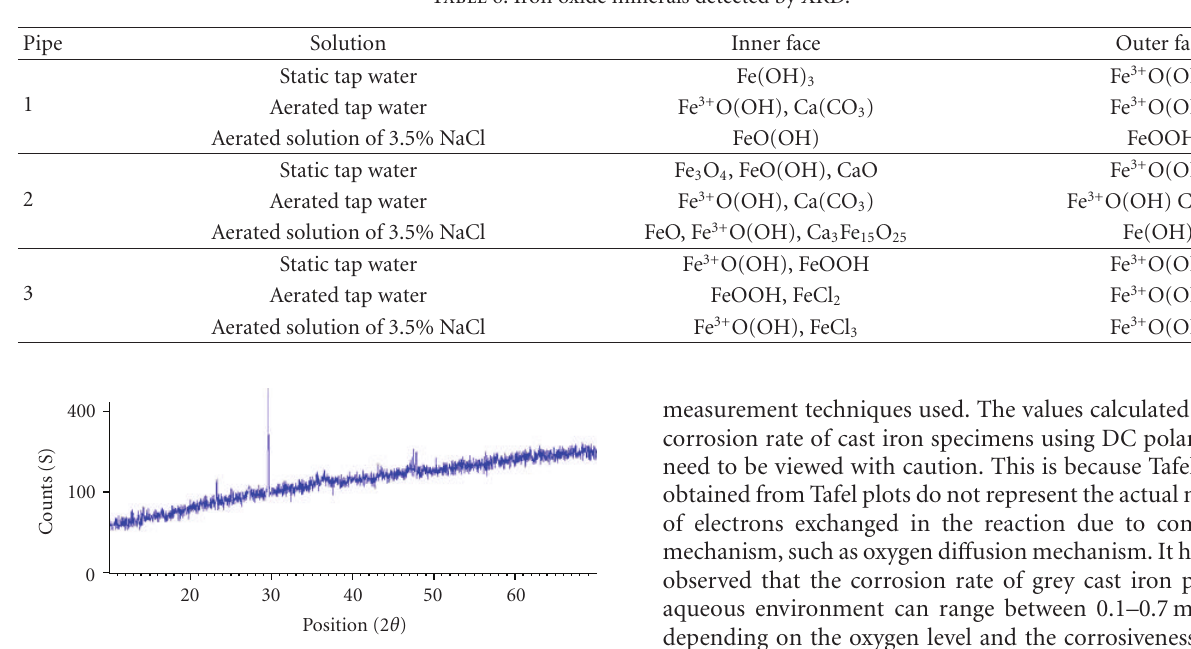
Table 6: Iron oxide minerals detected by XRD.